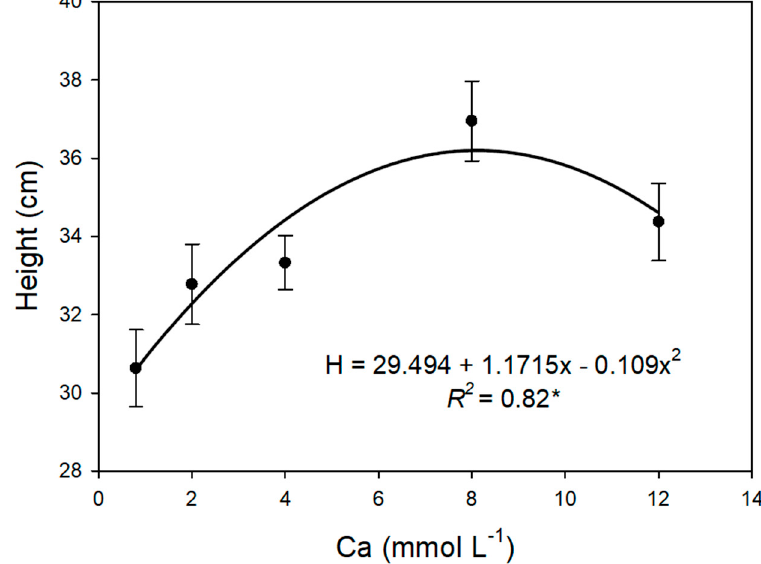
Figure 5. Effect of the calcium supply (mmol L − 1 ) on the height of eucalyptus seedlings. * Significant at p ≤ 0.05. The bars represent the standard error.